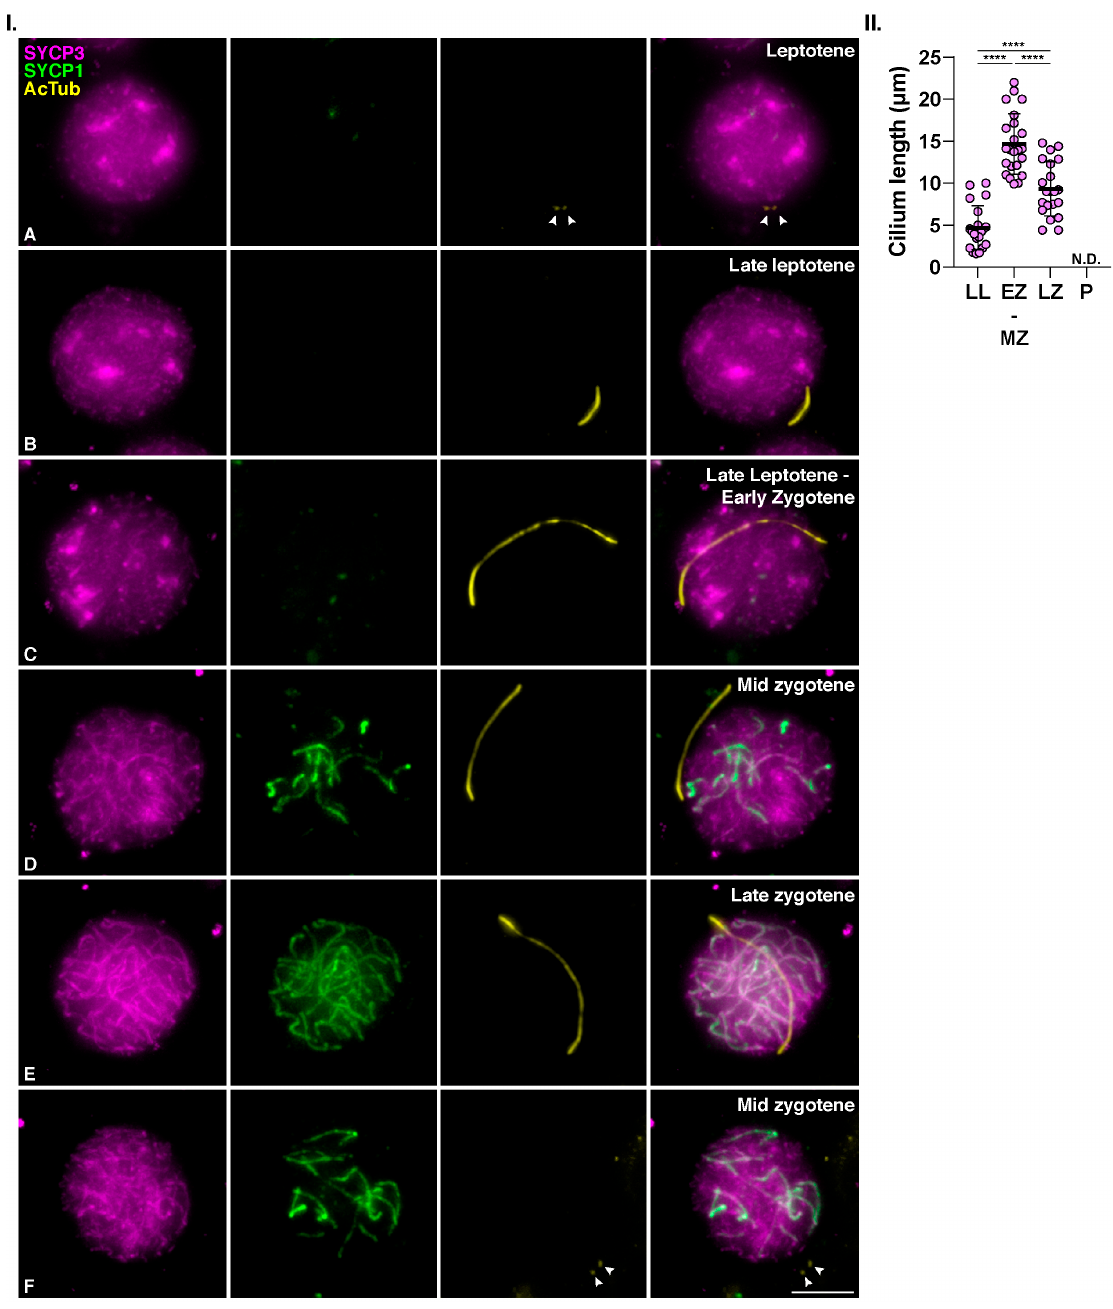
Figure 5. Mouse meiotic cilia appear at the onset of synapsis. ( I ) . Cilia are fully formed at mid zygotene. Triple immunolabelling of SYCP3 (magenta), SYCP1 (green), and acetylated tubulin (AcTub) (yellow) on squashed WT mouse spermatocytes at ( A ) Leptotene, ( B ) Late Leptotene with polymerizing primary cilium, ( C ) Leptotene to zygotene transition, Late leptotene-Early Zygotene with primary cilium, ( D ) Mid Zygotene with primary cilium, ( E ) Late Zygotene with primary cilium, and ( F ) Mid zygotene without cilium. White arrowheads in A and F indicate centrosomes localization. Scale bar in F represents 5 µm. ( II ) . Cilia length quantification. Graph represents the length of the cilia in spermatocytes at Late Leptotene, Early-Mid Zygotene, Late Zygotene, and Pachytene. Data represent mean ± SD, **** p < 0.0001, One-way ANOVA, a minimum of 20 spermatocytes quantified per zygotene stage, while n = 100 pachytene spermatocytes were analyzed, and none of them were ciliated.